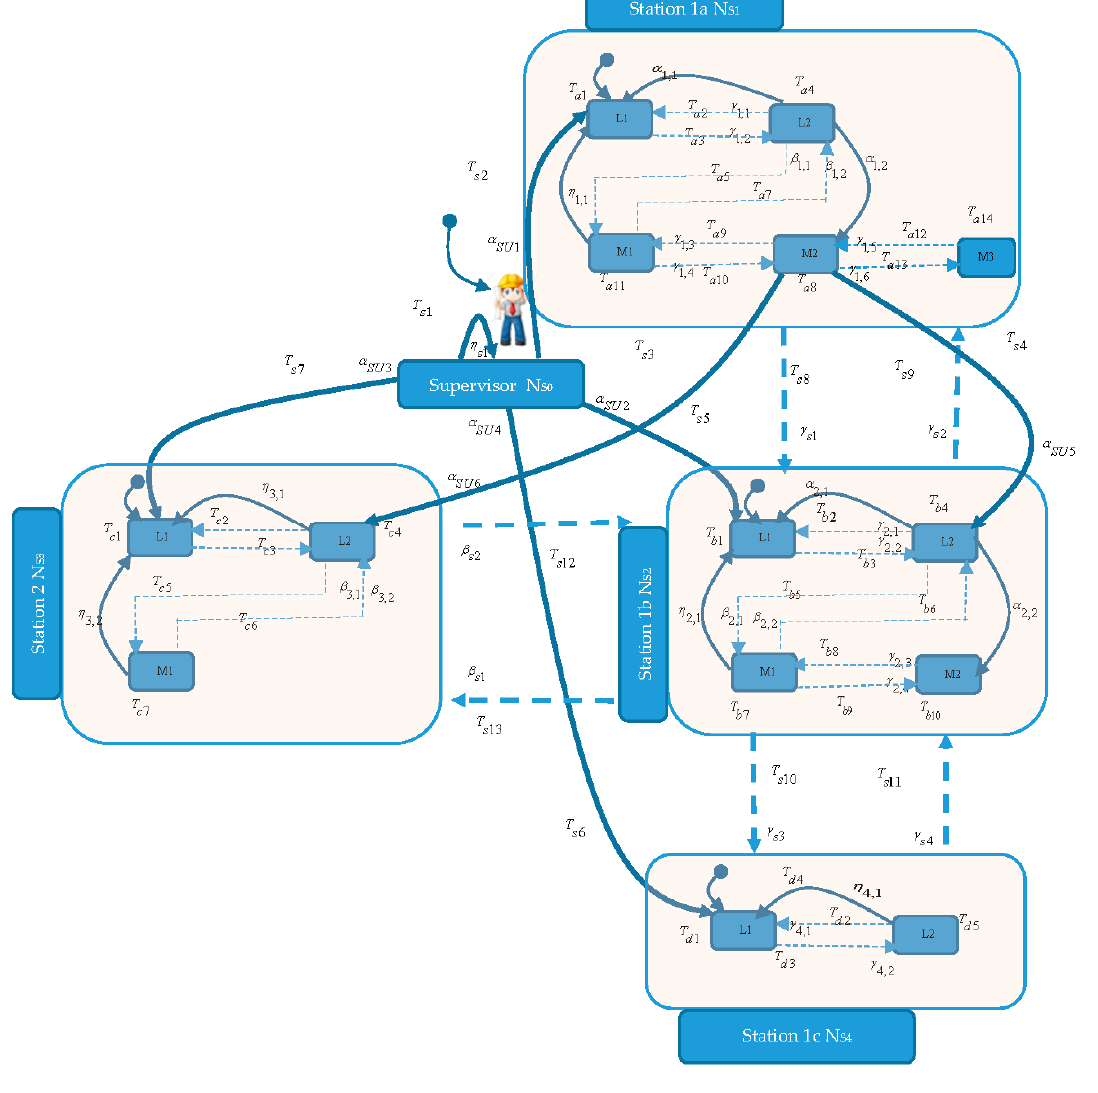
Figure 2. An example of a supervisor machine model.